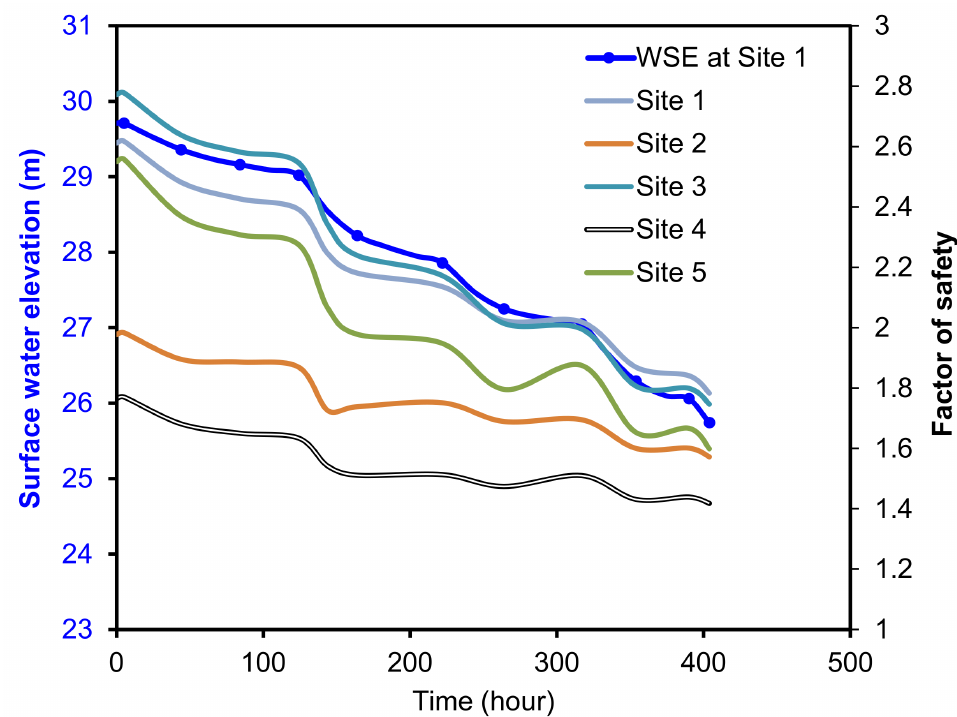
Figure 14. Changes in factor of safety with time during a step-down event.